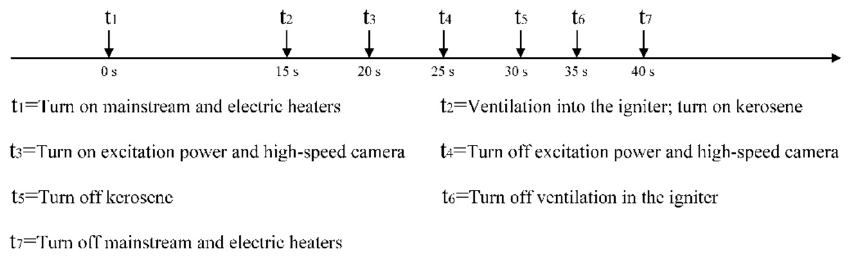
Figure 13. Hyperburner ignition test sequence.